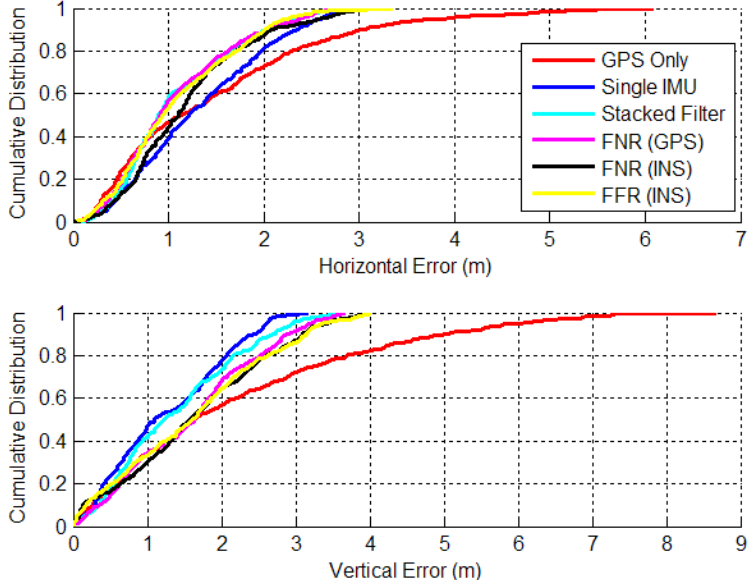
Figure 10. CD of Horizontal and Vertical Errors for Stacked and Federated (Residential Data